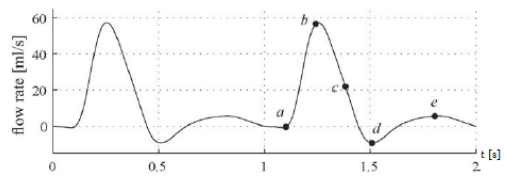
Figure 2. Prescribed blood flow rate [8], [9]: (a) end- diastole (b) peak-systole; (c) late-systole; (d) end-systole; (e)